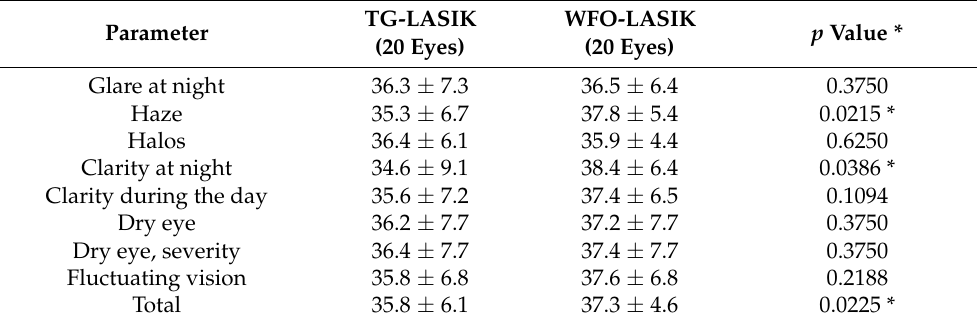
Table 6. Subjective quality of vision results obtained from questionnaire between TG-LASIK and WFO-LASIK groups after 3